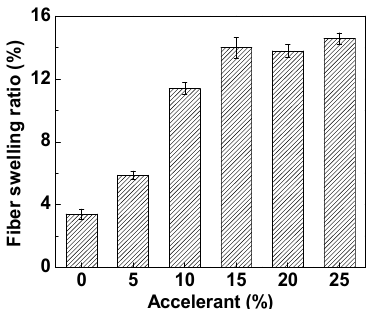
Figure 6. The swelling of PET fiber with different contents of accelerant in the D5 solvent.